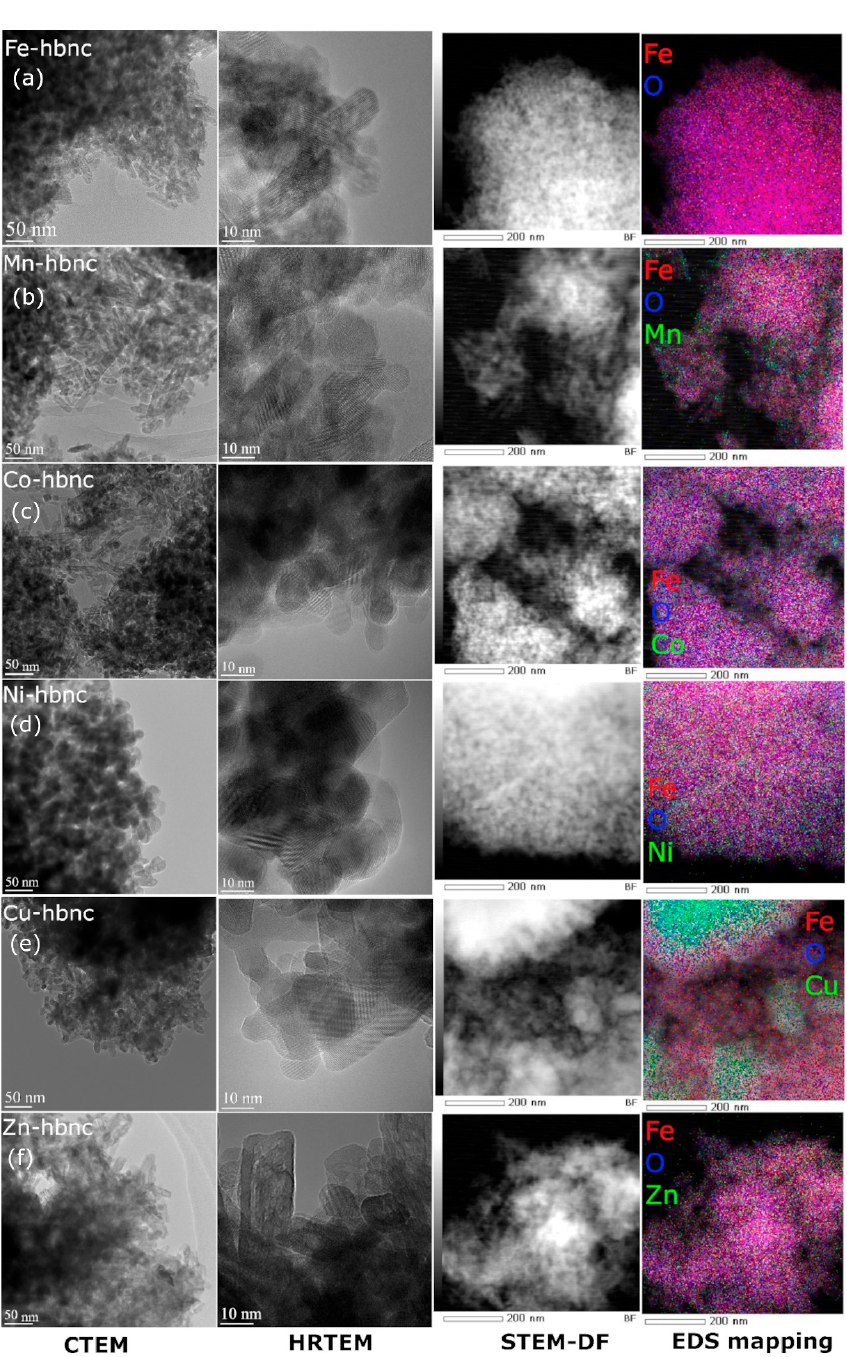
Figure 4. TEM results: CTEM, HRTEM, STEM, and EDS mappings for Fe-hbnc ( a ), Mn-hbnc ( b ), Co-hbnc ( c ), Ni-hbnc ( d ), Cu- hbnc ( e ), and Zn-hbnc ( f ). The undoped Fe-hbnc sample is composed of two subsystems of well-crystallized NPs: i) quasi-spherical NPs with 10 nm size ( α -Fe 2 O 3 ) and ii) nanorod-like NPs with a